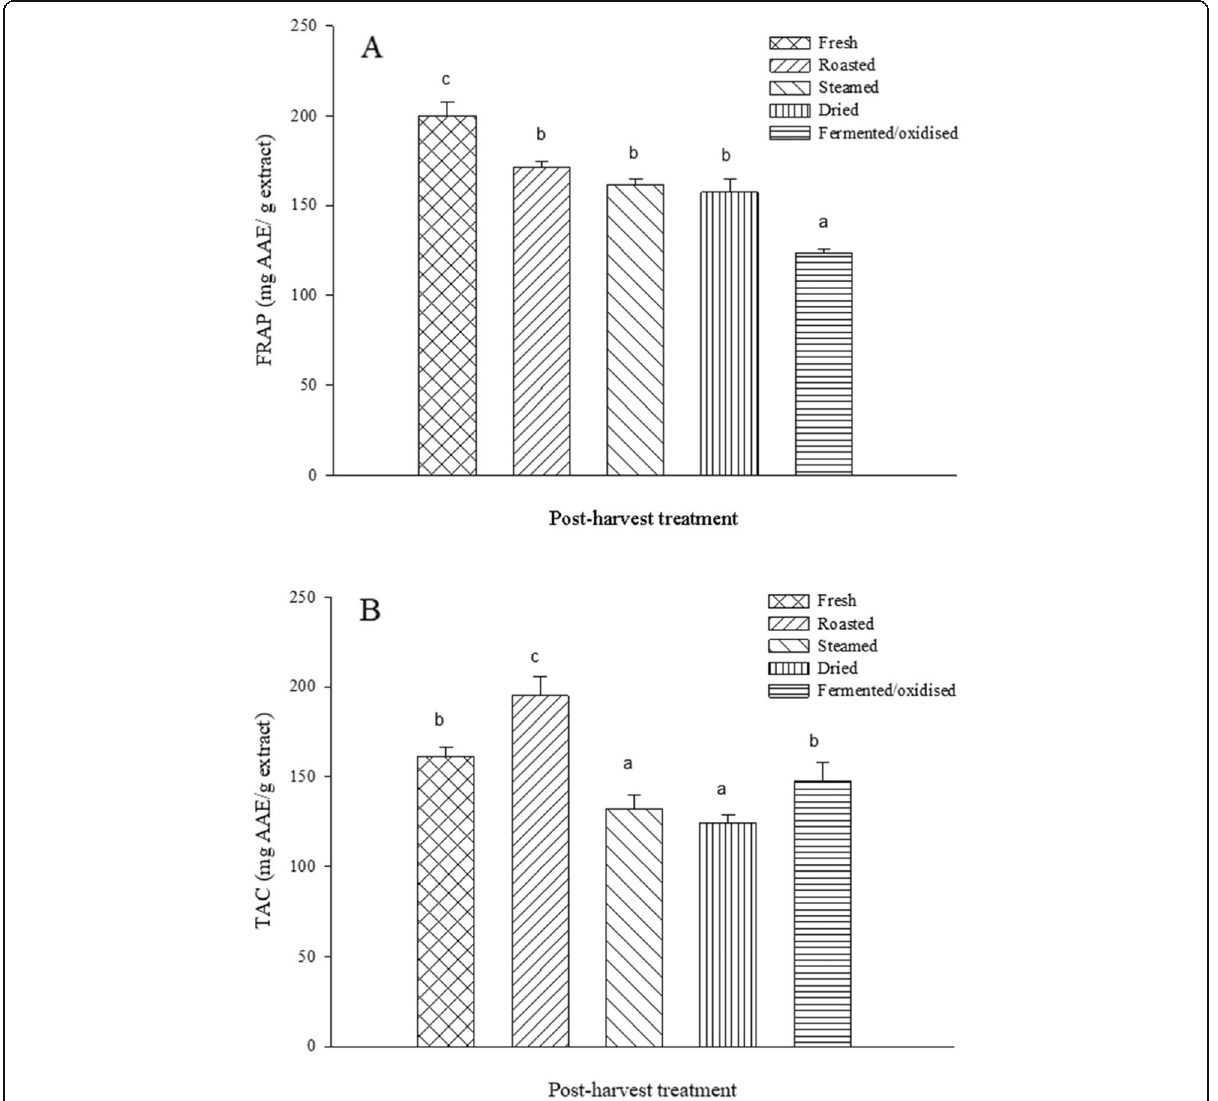
Fig. 4 Reducing capacity of fresh and processed Moringa oleifera leaf extracts. (A) Ferric Reducing Antioxidant Power (FRAP); (B) Total antioxidant capacity